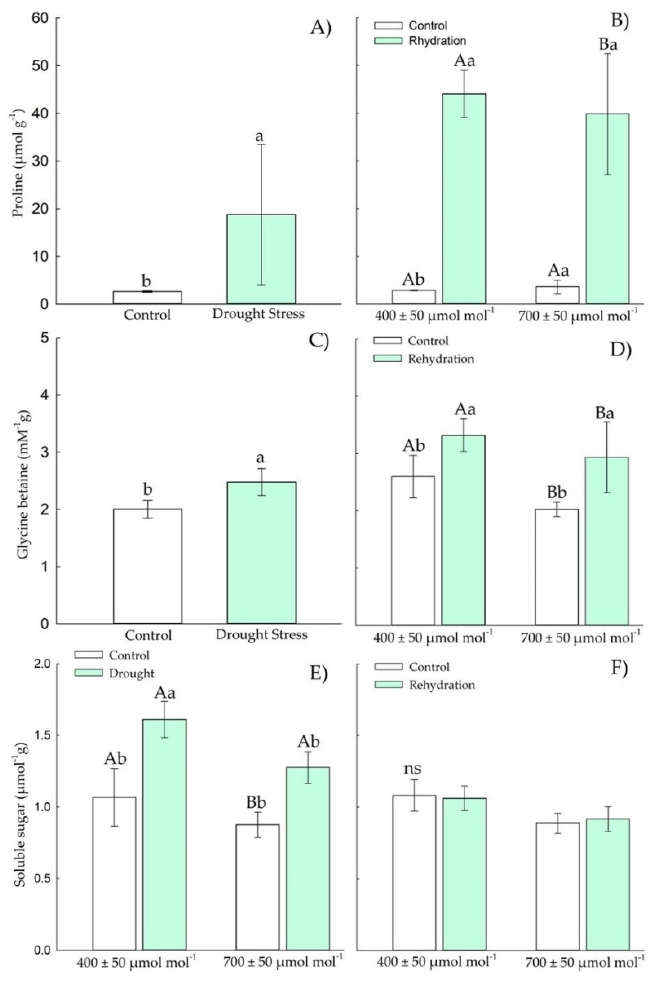
Figure 8. Effects of CO 2 concentration ( a [CO 2 ] = 400 µ mol mol − 1 and e [CO 2 ] = 700 µ mol mol − 1 ) and drought stress in A. buniifolius leaf proline ( A , B ), glycine betaine ( C , D ), soluble sugar ( E , F ). In plants sampled after drought stress ( A , C , E ) and rehydration ( B , D , F ) period. Different uppercase letters indicate a significant difference between values in different [CO 2 ] within the same water treatment, while different lowercase letters indicate significant differences between values of different water treatments within each [CO 2 ] level by Tukey’s test ( p ≤ 0.05). ns denotes non-significance ( p > 0.05). Error bars represent a 95% confidence